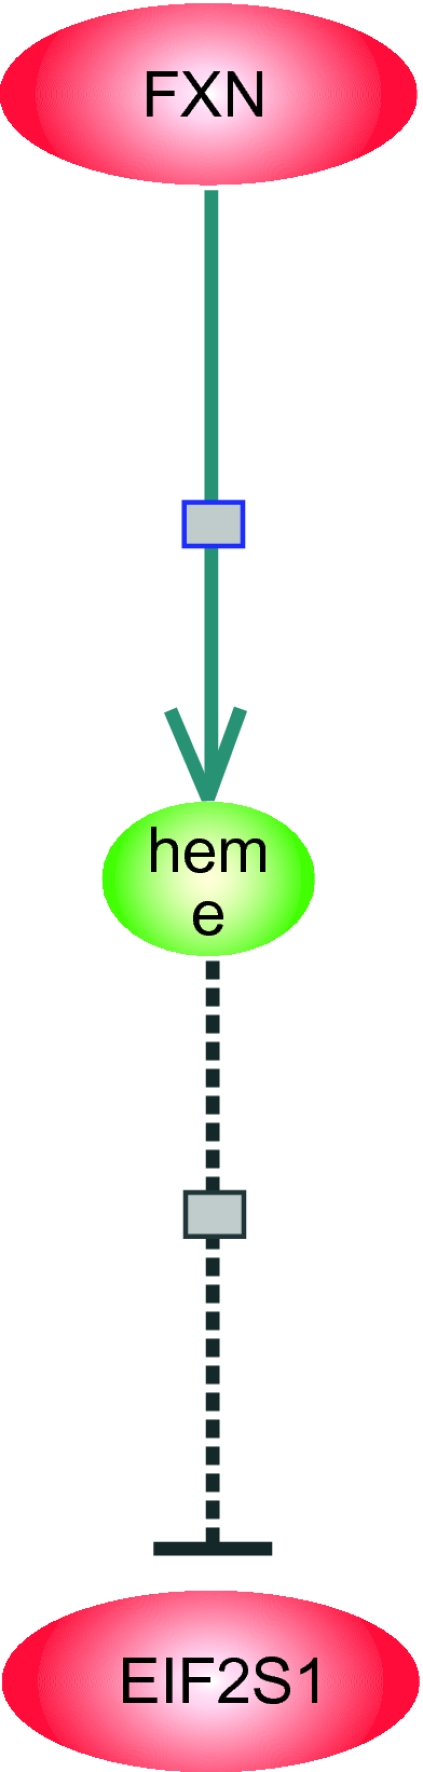
Pathway Assist™ diagram illustrating FXN and EIF2S1 relationships of Example 2